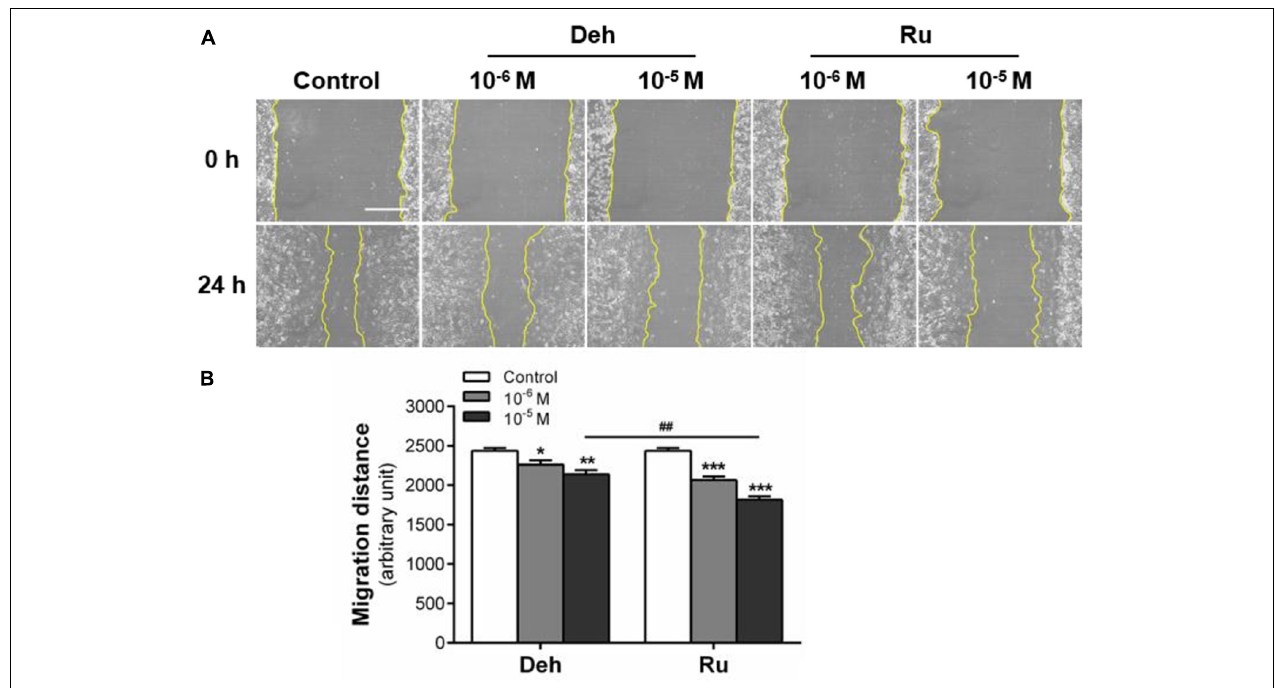
FIGURE 3 | Effect of dehydroaevodiamine and rutaecarpine on the migration of U87 cells. A wound healing assay was used to analyze the effect of compounds on the migration of U87 cells. (A) Typical images of wound healing assay were taken at 0 and 24 h about different treatment groups. Scale bar = 0.5 mm. (B) Quantitative data graph of wound healing assay. After 24 h treatment with 10 − 6 and 10 − 5 M dehydroaevodiamine or rutaecarpine or 0.1% DMSO, the distance of migration was counted. * p < 0.05, ** p < 0.01, *** p < 0.001 compared with control groups. ## p < 0.01, a comparison between Ru (10 − 5 M) and Deh (10 − 5 M) treated groups. All values are fold of control that was treated with the solvent and represent the mean ± SEM ( n = 3). SEM, standard error of the mean; Deh, dehydroaevodiamine; Ru,